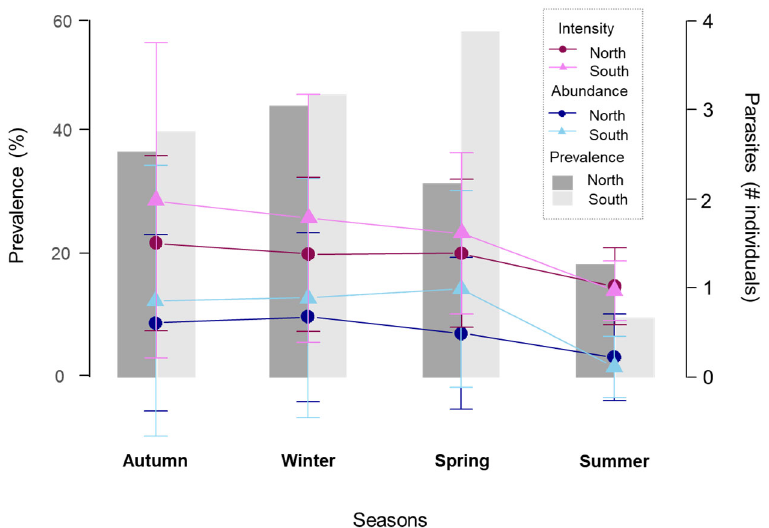
Figure 4. Nematode parasite prevalence, mean intensity, and abundance between coasts during the annual seasons. Table 3. Overall parasitic parameters during the annual season for sardines from the northern Catalan Coast and the southern Catalan Coast: N, number of sardines analysed; Ni, number of sardines infected by nematode parasites; Prevalence (%); Mean intensity ± SD; Mean abundance ± SD.